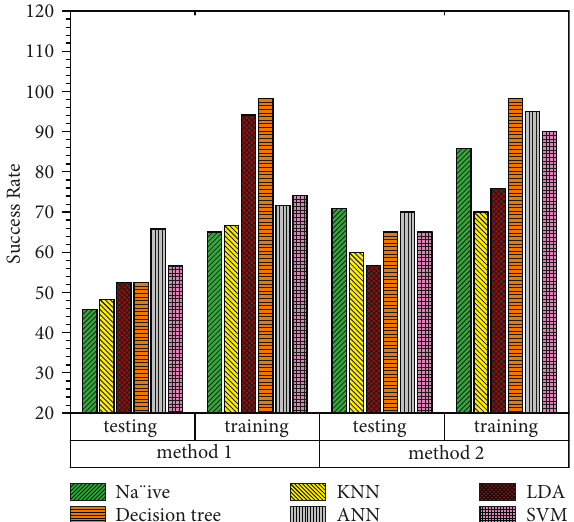
Figure 4: DL algorithm success rate comparison during training and testing for different